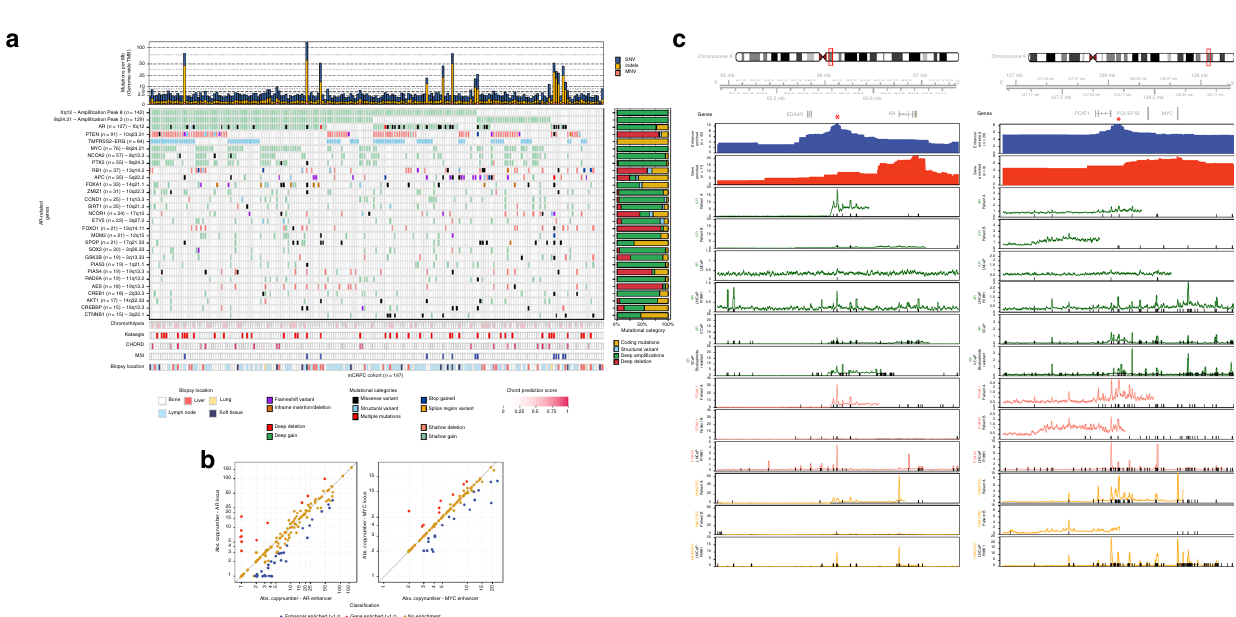
Fig. 4 WGS reveals novel insight into the various (non-coding) aberrations affecting AR regulation. a Mutational overview of top recurrently mutated genes affecting AR regulation and their putative enhancer foci (as detected by GISTIC2). The fi rst track represents the number of genomic mutations per Mbp (TMB) per SNV (blue), InDels (yellow), and MNV (orange) category genome-wide (square-root scale). Samples are sorted based on mutual-exclusivity of the depicted genes and foci. The heatmap displays the type of mutation(s) per sample, (light-)green or (light-)red backgrounds depict copy-number aberrations while the inner square depicts the type of (coding) mutation(s). Relative proportions of mutational categories (coding mutations [SNV, InDels and MNV] (yellow), SV (blue), deep ampli fi cations (green), and deep deletions (red)) per gene and foci are shown in the bar plot next to the heatmap. The presence of chromothripsis (light pink), kataegis (red), CHORD prediction score (HR-de fi ciency) (pink gradient), MSI status (dark blue), and biopsy location are shown as bottom tracks. b Overview of the copy-number deviations between putative enhancer and gene regions for AR and MYC . Samples were categorized as enhancer- (blue) or gene- (red) enriched if enhancer-to-gene ratio deviated >1 studentized residual (residual in standard deviation units) from a 1:1 ratio. c Copy number and ChIP-seq pro fi les surrounding the AR and PCAT1/MYC gene loci (with 1.25 additional Mbp up-/downstream). The upper panel displays the selected genomic window and the overlapping genes. The fi rst and second track display the aggregated mean copy number (per 0.1 Mbp window) of the enhancer- and gene-enriched samples, respectively. These pro fi les identify distinct ampli fi ed regions (indicated by red asterisk) in proximity to the respective gene bodies. The 3th to 8th tracks represent AR ChIP-seq pro fi les (median read-coverage per 0.1 Mbp windows) in two mCRPC patients (# 3 and 4), LNCaP (# 5) and LNCaP with R1881 treatment (# 6), VCaP (# 7) and bicalutamide-resistant VCaP (# 8). The 9th to 11th tracks represent FOXA1 ChIP-seq pro fi les (median read-coverage per 0.1 Mbp windows) in two mCRPC patients (#9 and 10) and LNCaP with R1881 treatment (# 11). The 12th to 14th tracks represent H3K27ac ChIP-seq pro fi les (median read-coverage per 0.1 Mbp windows) in two mCRPC patients (# 12 and 13) and LNCaP with R1881 treatment (# 14) re fl ecting active enhancer regions. ChIP-seq peaks (MACS/MACS2; q < 0.01) are shown as black lines